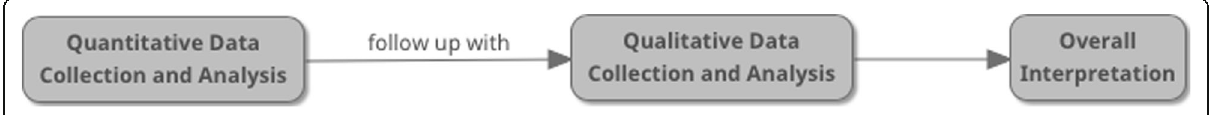
Fig. 2 Mixed-methods sequential explanatory model adapted from Creswell (2013)